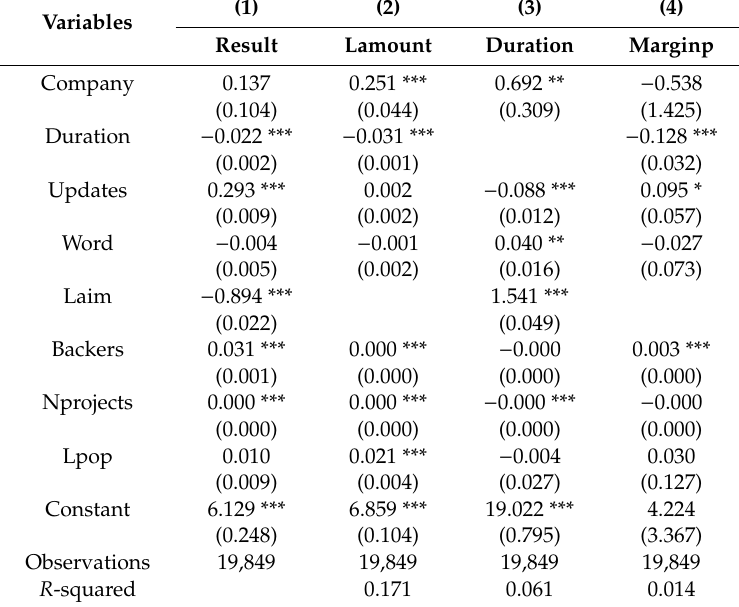
Table 10. U.S. company results. This table reports results of regression analysis of the success, amount raised, duration, and margin (%) variables when a U.S. initiator is a company. We controlled for di ff erent variables. Table 3 defines all the